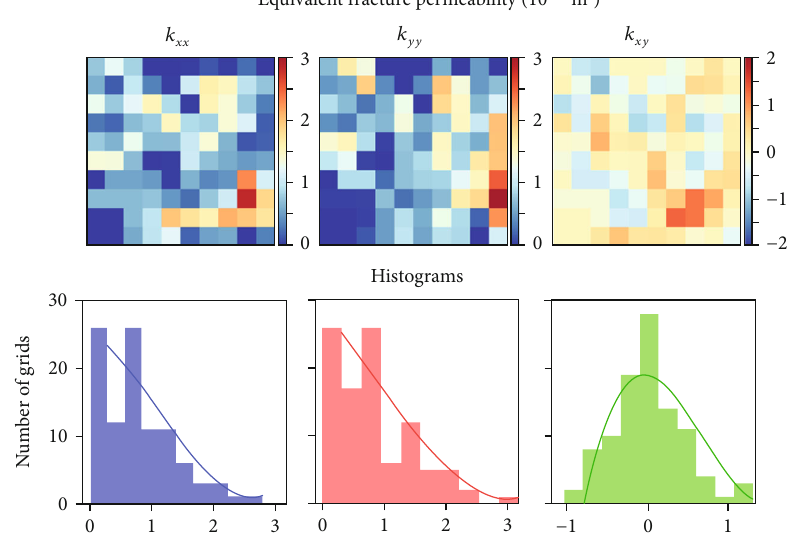
k k xx , yy , and xy for